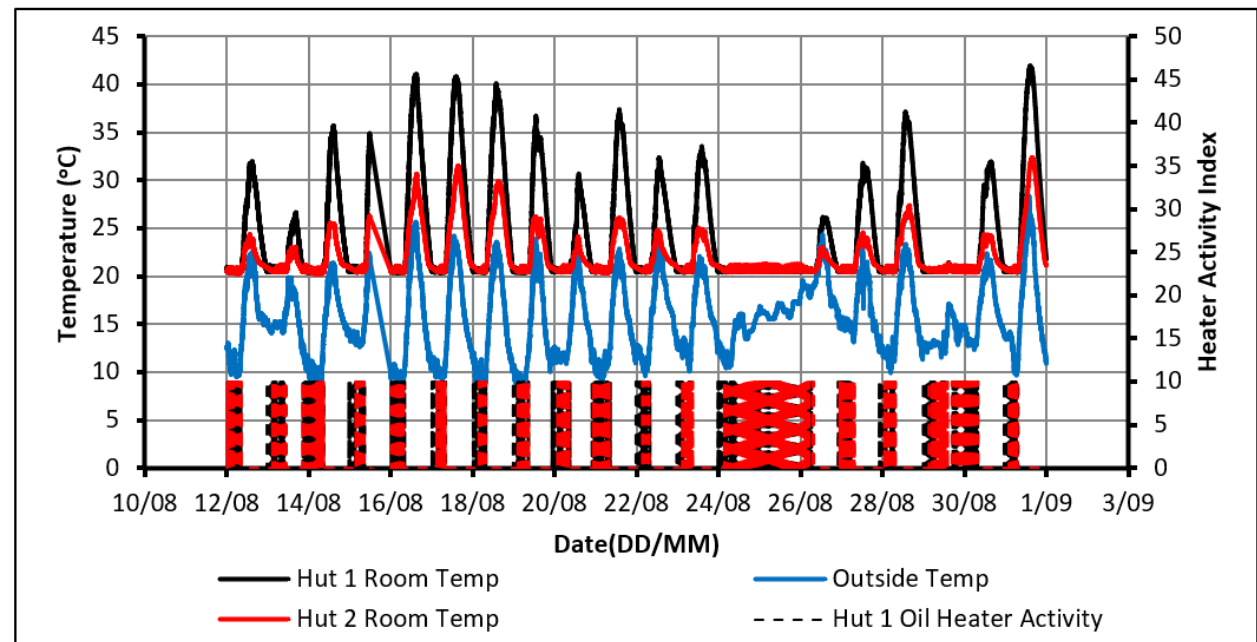
Figure 6. Temperature profiles and oil heater activity (20 – 22 °C temperature